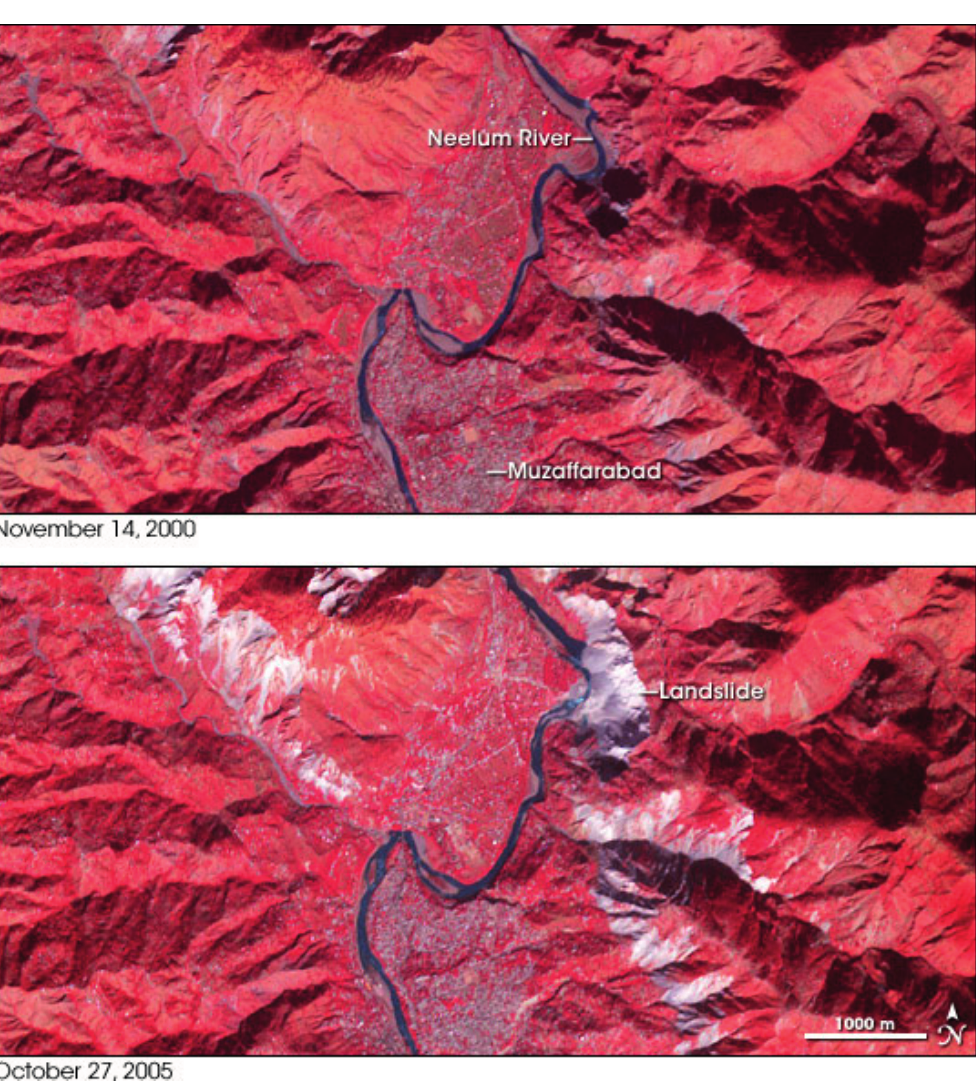
Figure 2. An area near Kashmir, Pakistan, experienced local landslides in the year 2005: images are made from near-infrared, red, and green light, so vegetation is depicted in red, water in blue, and the effect of the landslide in white or light gray (source: NASA images by Robert Simmon, based on ASTER